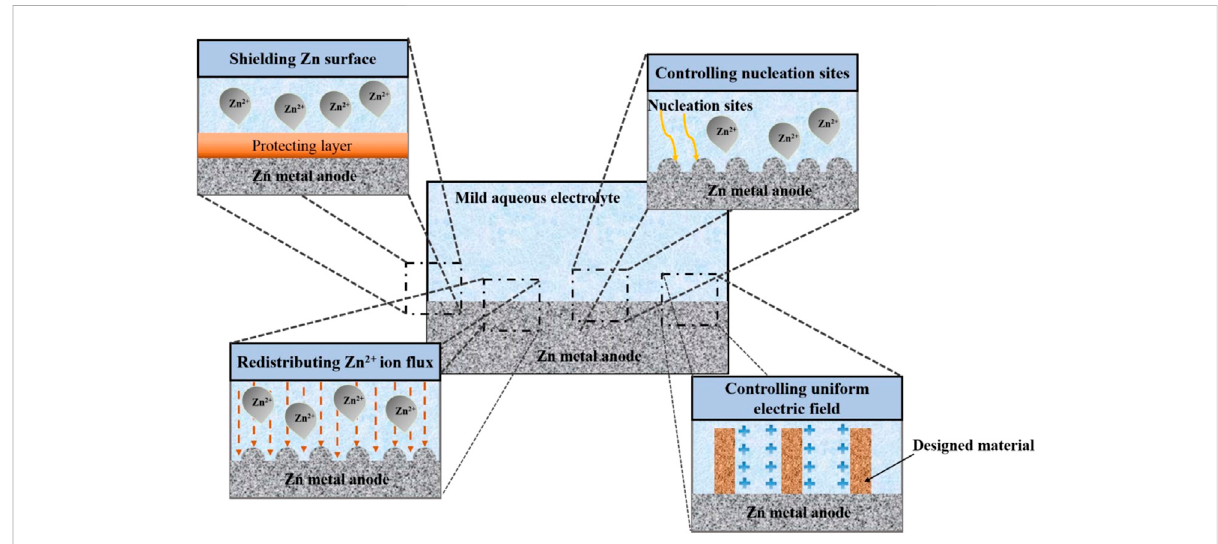
FIGURE 5 Techniques for modifying Zn metal anodes to improve their electrochemical performance. Reproduced with permission (Huy, Hieu, and Hur 2021). Copyright (2021),